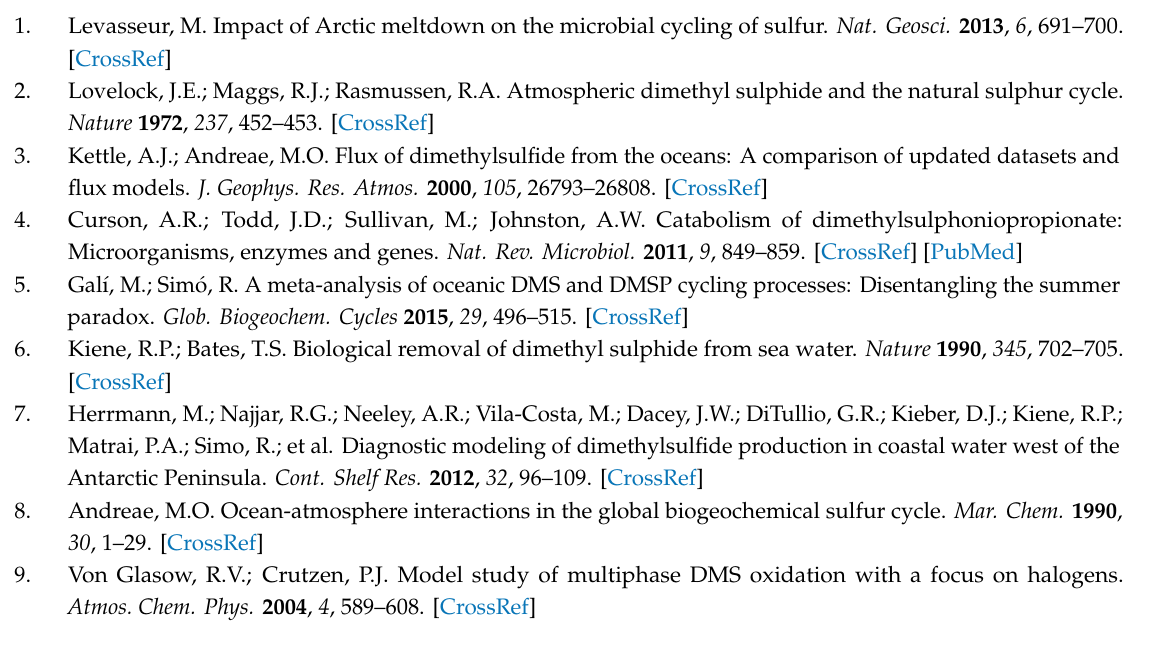
Figure S1: Typical time course experiments at the coastal station L4 showing the amount of radioactive carbon from the added 14 C 2 -DMSO that was used during (a) assimilation into particulate material and (b) oxidation to ≤ 1.6 nM. Where DPM is disintegrations per minute (1 DPM = 4.51 × 10 − 13 Ci). 14 CO 2 after radiotracer addition of Error bars represent ± 1 standard deviation of three replicate